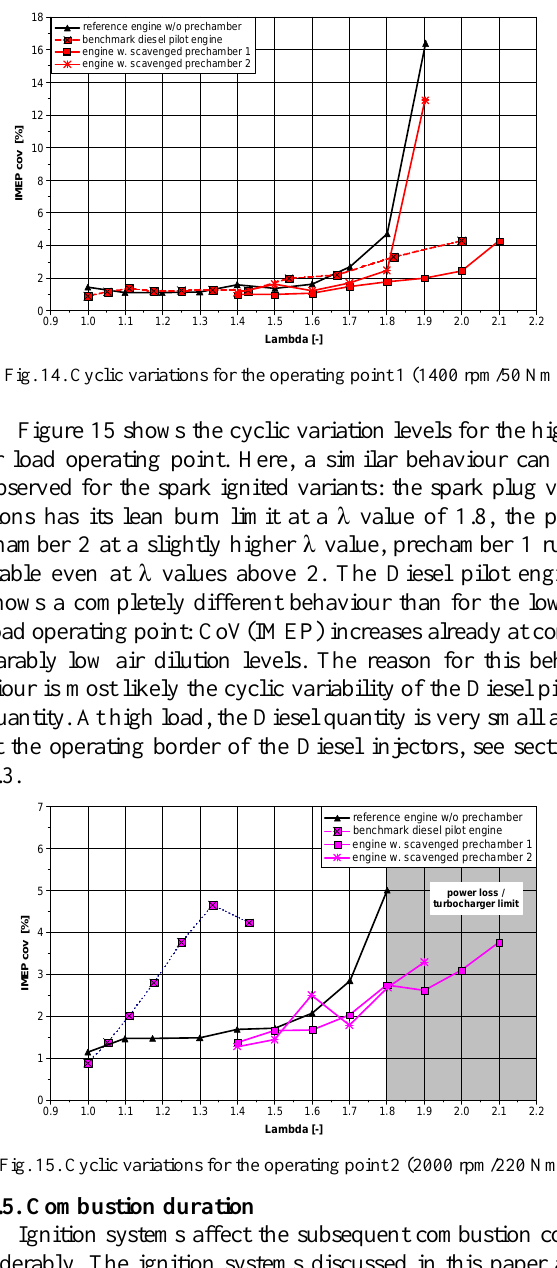
Fig. 17. Combustion durations for the operating point 2 (2000 rpm/220